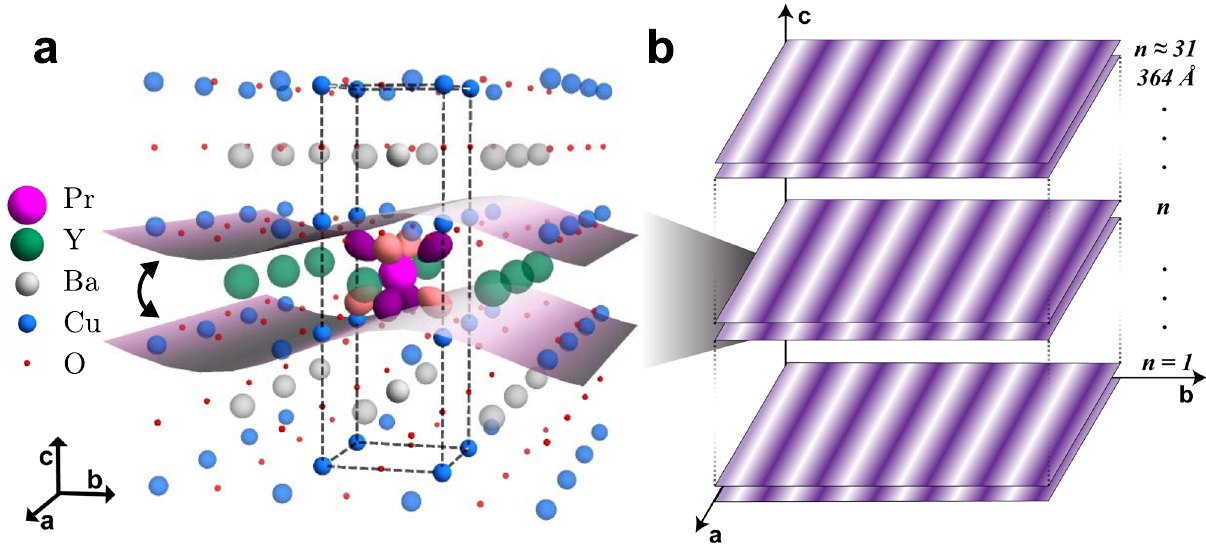
Fig. 1 | Stabilizing three-dimensional charge order. a The extended unit cell (dashed box) of Pr x Y 1 − x Ba 2 Cu 3 O 7 illustrating the charge order coupling between adjacentCuO 2 planesthatariseswhenintroducingPrattheYsites.ThePr4 f z ð x 2 (cid:1) y 2 Þ